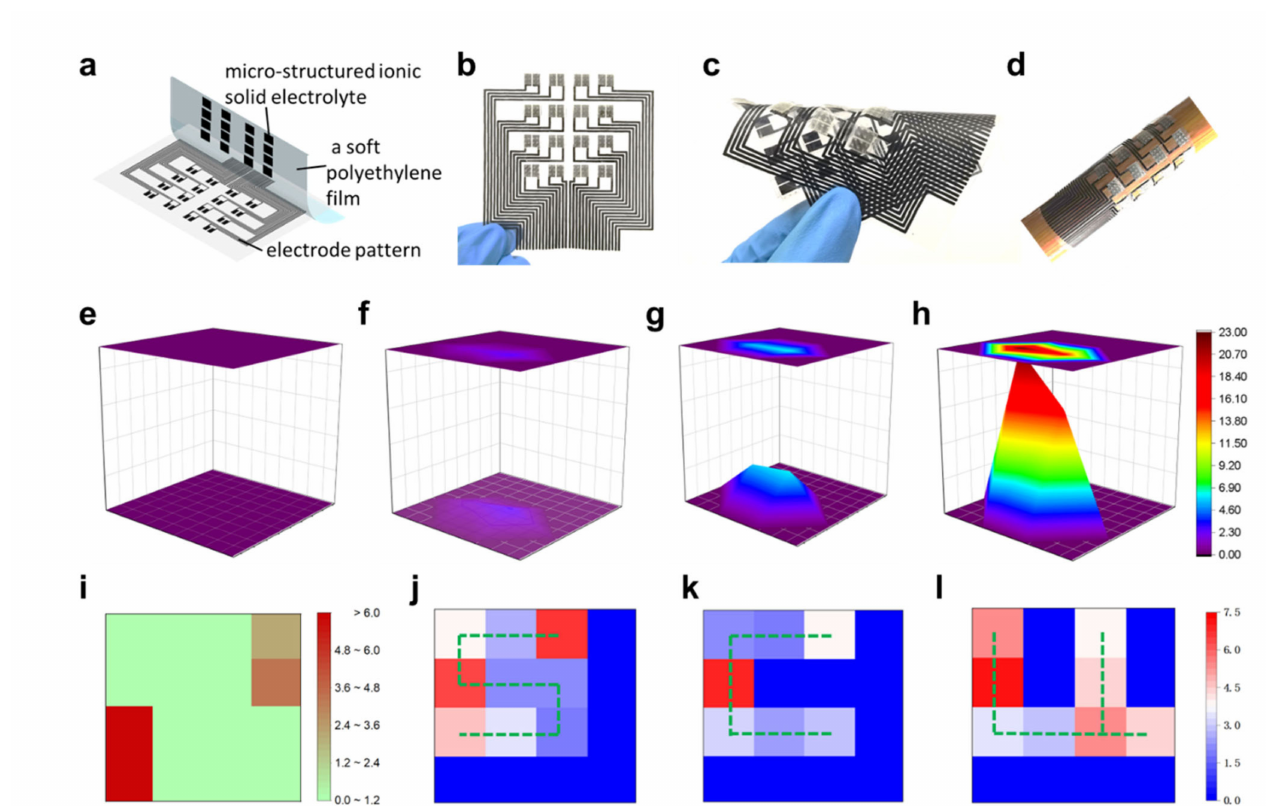
Figure 7. Pressure-sensitive electronic skin for detecting pressure magnitude and pressure distribu- tion. ( a ) Schematic depicting the device structure and electrode configuration of the pressure-sensitive electronic skin. ( b ) Digital picture of the fabricated pressure-sensitive electronic skin. ( c , d ) Digital photographs showing the pressure-sensitive electronic skin in different bending status, revealing good flexibility of the electronic skin. ( e – h ) Spatial mappings of capacitance signal variations when a single-point pressure with different magnitudes (0 kPa, 28.5 kPa, 63.3 kPa and 143.8 kPa, respec- tively) is applied on the electronic skin. ( i ) Spatial mappings of capacitance signal variations when two pressures of different magnitudes are applied on the diagonal corners of the electronic